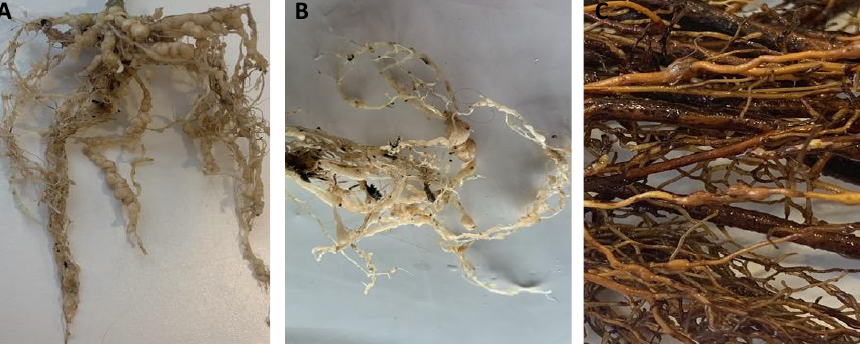
Figure 3 . Below-ground symptoms of Meloidogyne hapla attack (galls). ( A , B ): potato; ( C ): grape- vine.